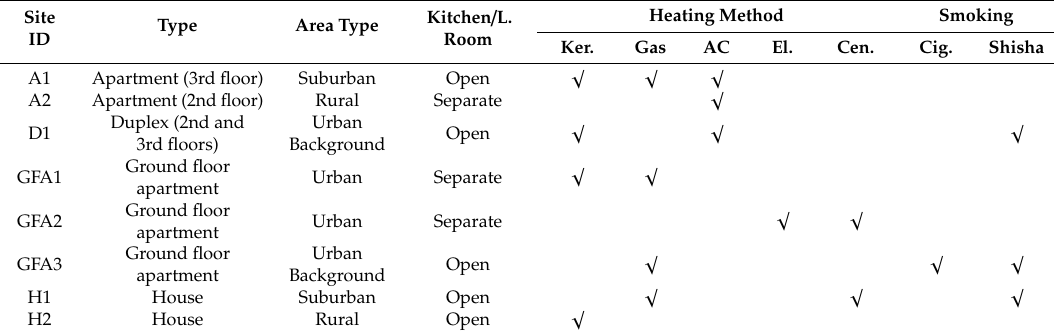
Figure 1. A map showing the Amman metropolitan region with the locations of the selected indoor environment study sites. The type of dwelling is referred to as: (A) apartment, (H) house, (D) duplex apartment, and (GFA) ground floor apartment. Table 1 provides additional details for each dwelling. Table 1. Characteristics of the selected residential indoor environments. The heating method refers to: kerosene heater (Ker.), natural gas heater (Gas), air conditioning system (AC), electric heaters (El.), and central heating system (Cen.). Cigarette smoking is denoted as